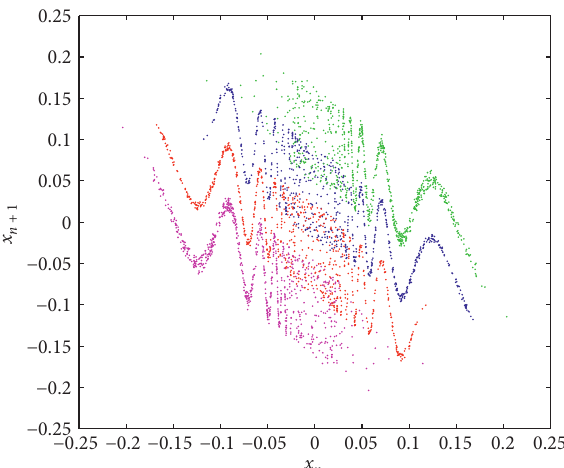
Figure 9: Four coexisting chaotic attractors for different initial conditions and system parameters A � 0 . 05 , B � 0 , C � 1 and μ � 0 . 3: blue � 0 . 1, red attractor for x attractor for x 0